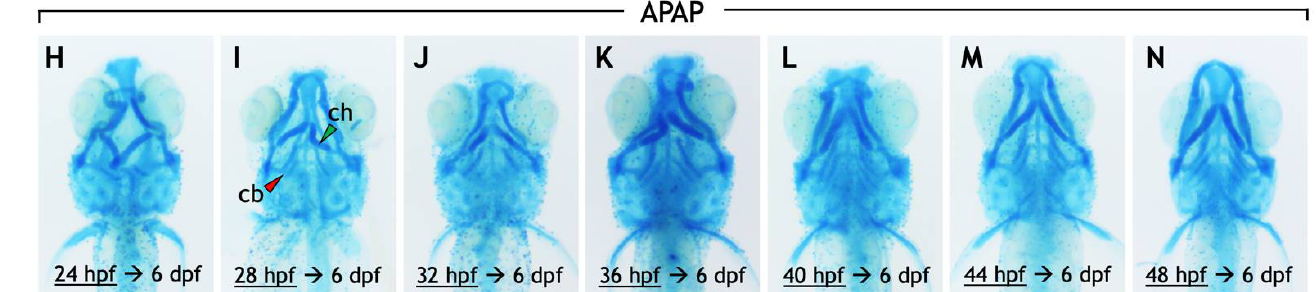
Figure 2. Exposure to acetaminophen, but not a non-hepatoxic analog, disrupts the development and morphology of craniofacial cartilages. ( A – N ) Ventral views of 6-dpf larvae stained with alcian blue. Compared to untreated larvae ( A ), those treated continuously with 3-acetamidophenol (3.9 mM), a non-hepatotoxic acetaminophen analog ( B ), have a reduced body size but with all craniofacial cartilages intact. ( C – N ) APAP treatment (3.9 mM) was initiated at the timepoints indicated then continuously through 6 dpf. The effects on the cartilages of the viscerocranium (labeled in ( A )), in both their presence and morphology, are generally less severe as the initiation of treatment is delayed ( C – N ). In a larva treated with APAP from 2 hpf ( C ), all cartilages of the viscerocranium are missing, making visible cartilages of the neurocranium, most prominently the ethmoid plate (ep) and the bilateral trabeculae (tr). These cartilages were clearly visible in all larvae in all treatment groups. Incrementally delaying treatment results in the restoration of cartilages derived from the first and second pharyngeal arches (e.g., Meckel’s cartilage) earliest, followed by cartilages derived from the third through seventh pharyngeal arches (ceratobranchial cartilages). With treatment delayed to 10 hpf, the palatoquadrate (pq) and ventral ceratohyal (ch) cartilages are more frequently present (black and white arrowheads in E, respectively). When treatment is delayed to at least 20 hpf, the ventral ceratohyal cartilages tend to be oriented posteriorly rather than anteriorly (compare yellow arrowhead in ( G ) with morphology in ( A )), and Meckel’s cartilage (mc) becomes more frequent (blue arrowhead in ( G )) though misshapen. The ventral ceratohyal cartilages also begin to be oriented anteriorly (green arrowhead in ( I )). Treatment at 28 hpf restores a reduced number of ceratobranchial cartilages in most larvae (red arrowhead in ( I )), though they can appear as early as with a 24 hpf treatment. One representative larva is shown from each treatment group, though the effects vary J. Dev. Biol. 2022 , 10 , x FOR PEER REVIEW within each treatment group. Scale bar (in ( A )) for ( A – N ), 250 µ m.